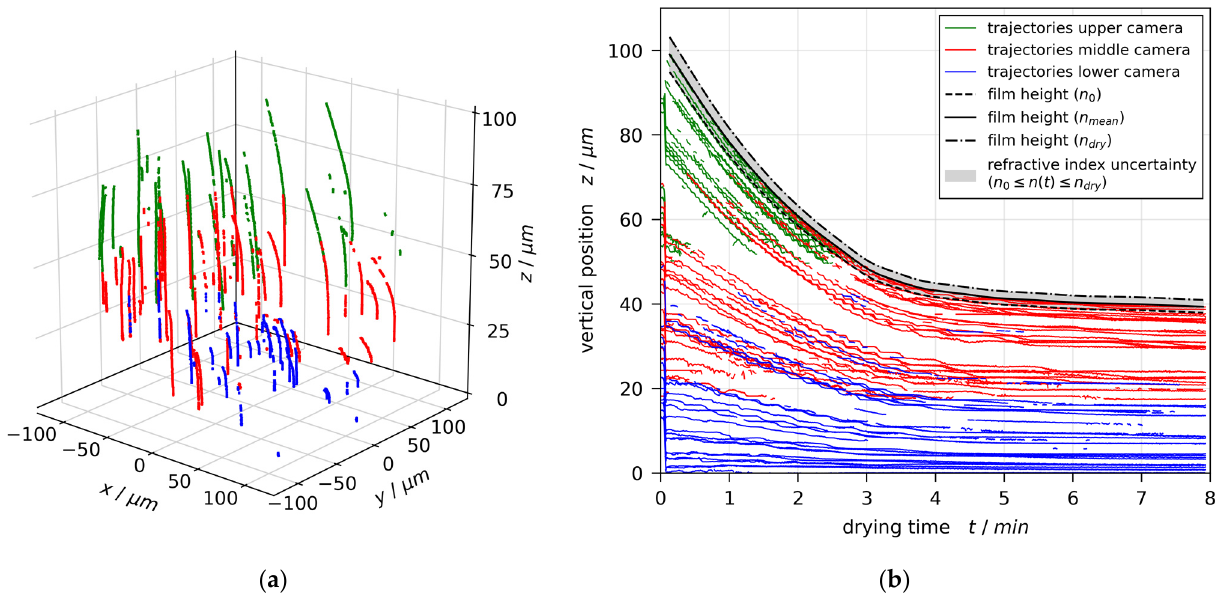
Figure 3. Flow field in a poly(vinyl acetate)-methanol film ( X 0 = 1 g MeOH / g PVAc and h gap = 200 µ m ), drying at T substrate = 20 ◦ C and otherwise ambient conditions, measured with 3D- µ PTV and evaluated with mean refractive index n mean . The flow field is dominated by film shrinkage. ( a ) The 3D tracer particle trajectories. ( b ) Transient vertical tracer particle positions. The extracted drying curves are additionally given for an evaluation with the refractive index of the coating solution n 0 and the dry polymer n dry , respectively (black